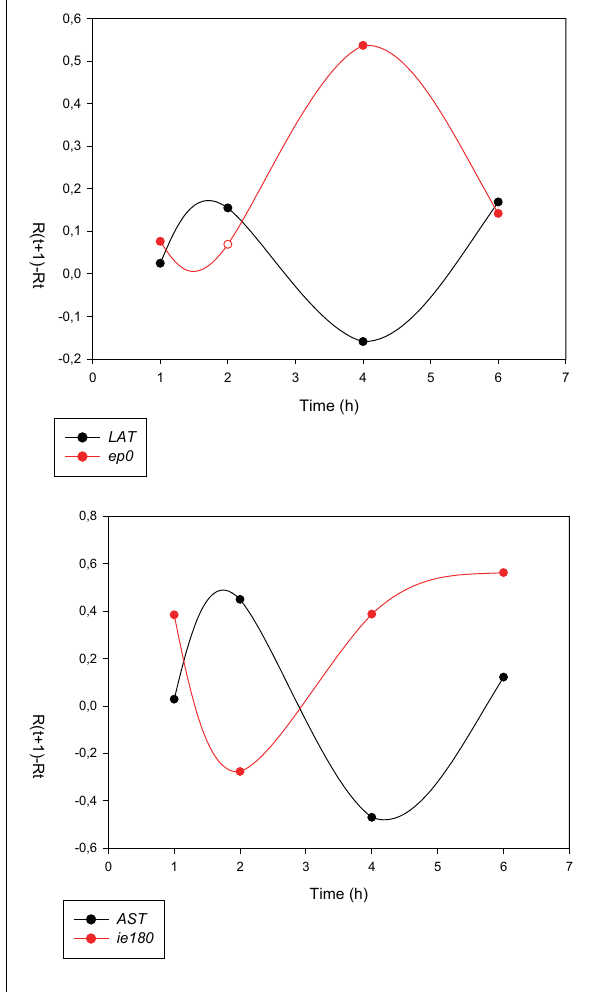
FIGURE 5 | Inverse expression pattern between the sense and antisense transcripts of pseudorabies virus. The transcription rates ( R (cid:2) values) of sense (mRNAs) and antisense RNAs exhibit reciprocal relationships [67].That is, high transcriptional activity of mRNAs results in a decrease in the transcription rate of the antisense transcripts, and vice versa